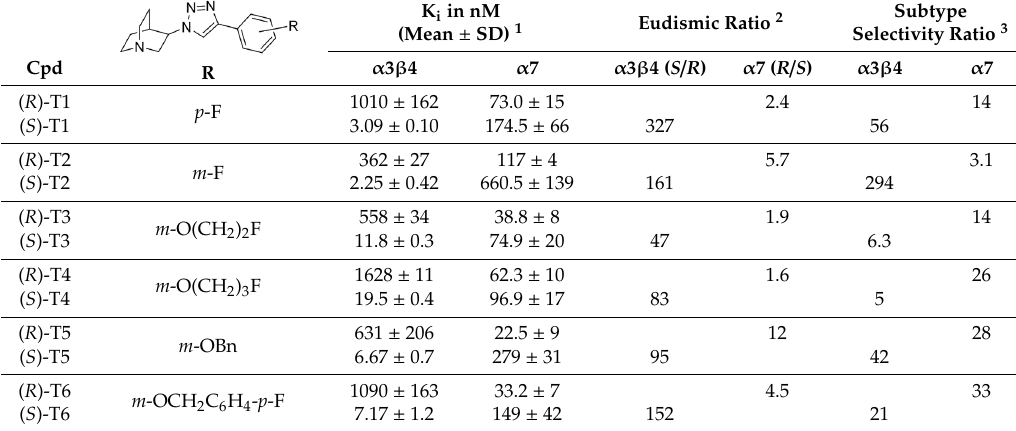
Table 1. Structures, binding a ffi nities, eudismic ratios, and subtype selectivity ratios of six enantiomeric pairs T1-T6.